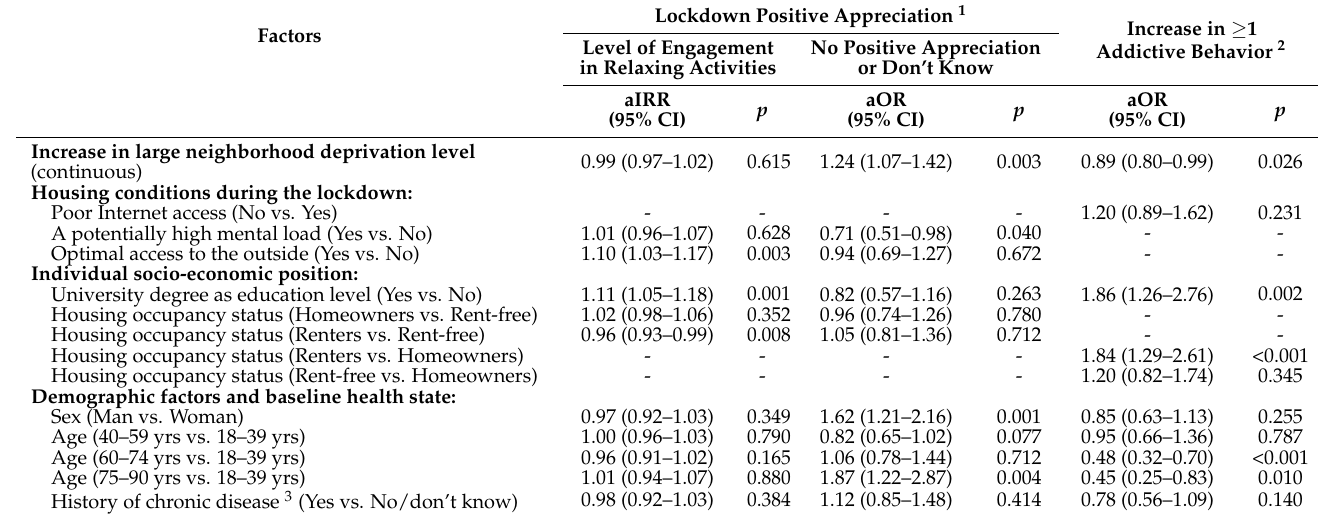
Table 4. Factors independently associated with lockdown positive appreciation and addictive behav- iors’ endpoints in the adult population during the COVID-19 lockdown (R é -Conf-ISS